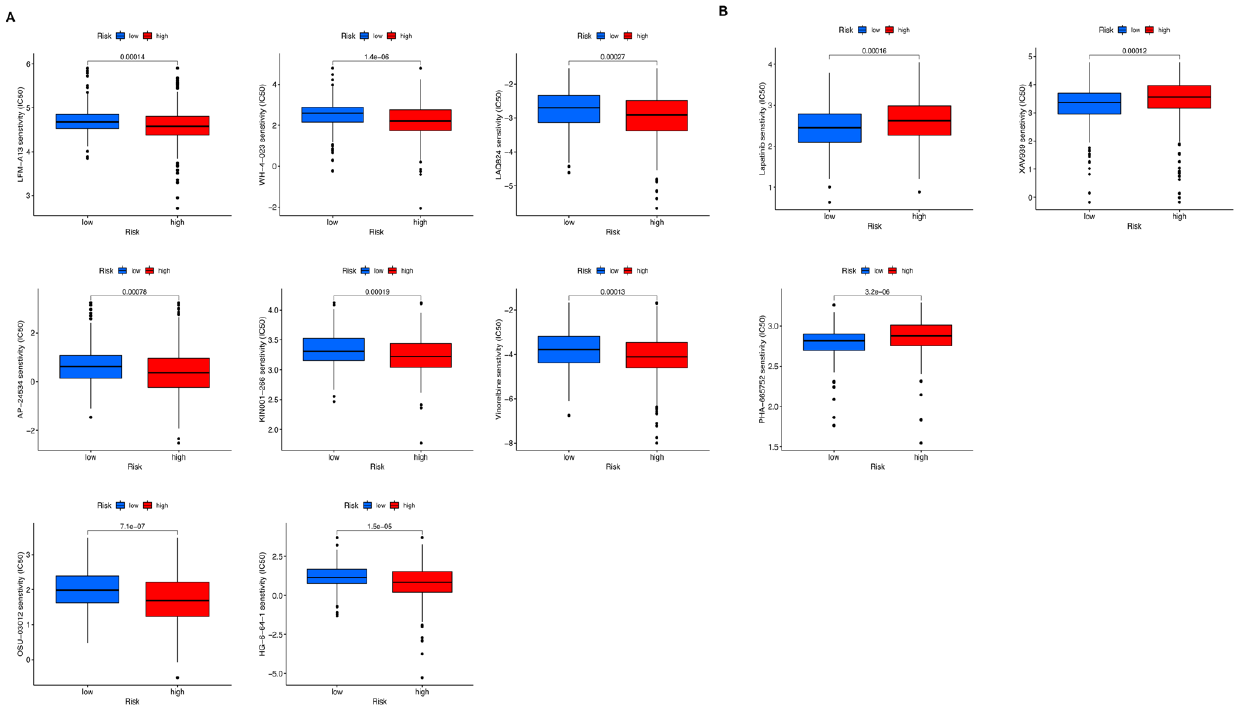
Figure 8. Potential drugs for endometrial cancer patients. ( A ) Potential drugs for patients in the high ‐ risk group. ( B ) Potential drugs for patients in the low ‐ risk group.